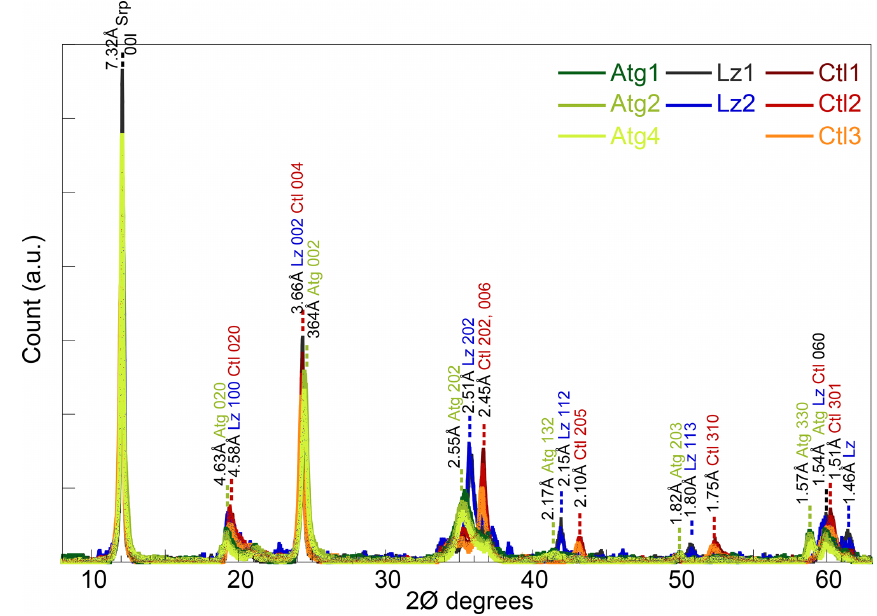
Figure 1. Powder XRD patterns of the eight serpentine samples selected for this study (lizardite: Lz1, Lz2; chrysotile: Ctl1, Ctl2, Ctl3; antigorite: Atg1, Atg2,